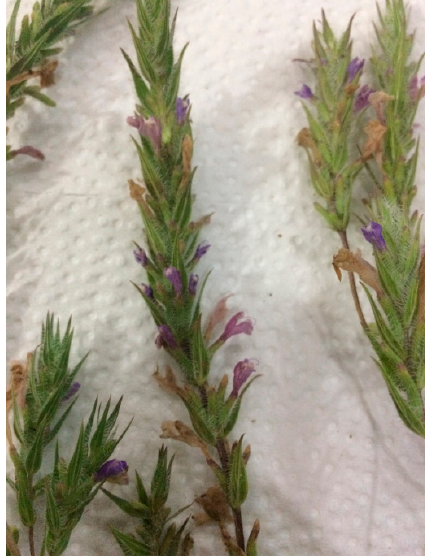
Figure 1. Image of the Z. taurica subsp. taurica.